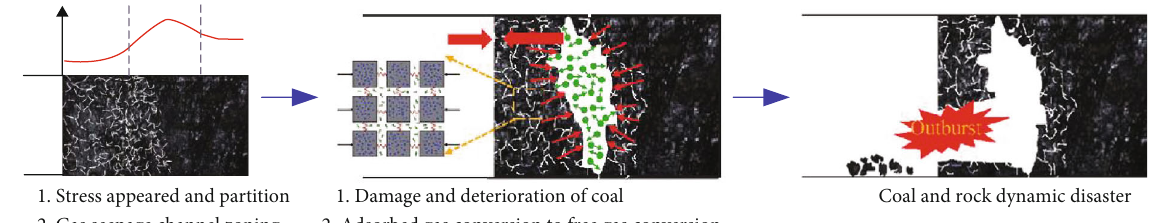
Figure 19: Stress appearance-coal damage-gas seepage-dynamic disaster evolution